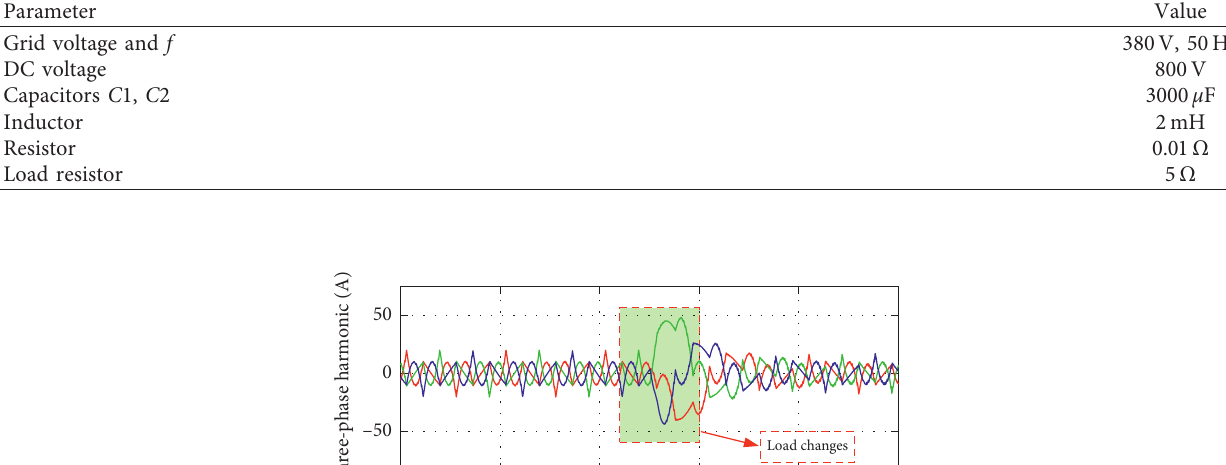
Table 1: Parameters of the simulation model.